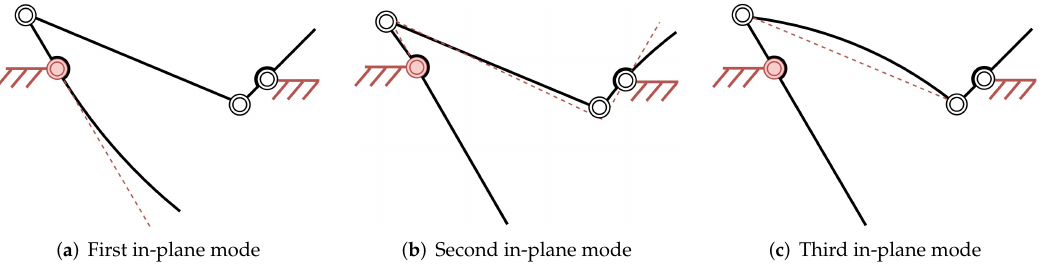
Figure 2. In-plane mode shapes of the balanced inverted four-bar mechanism assuming an infinitely stiff actuator in the first base pivot, shown in